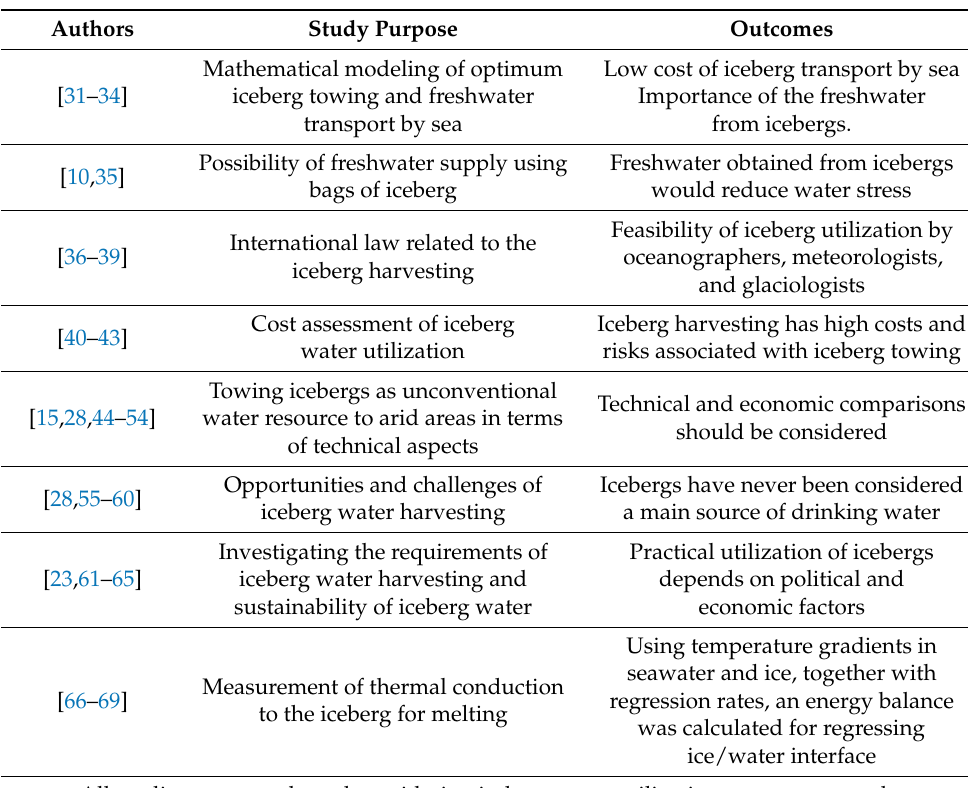
Table 2. Summary of results of the systematic literature